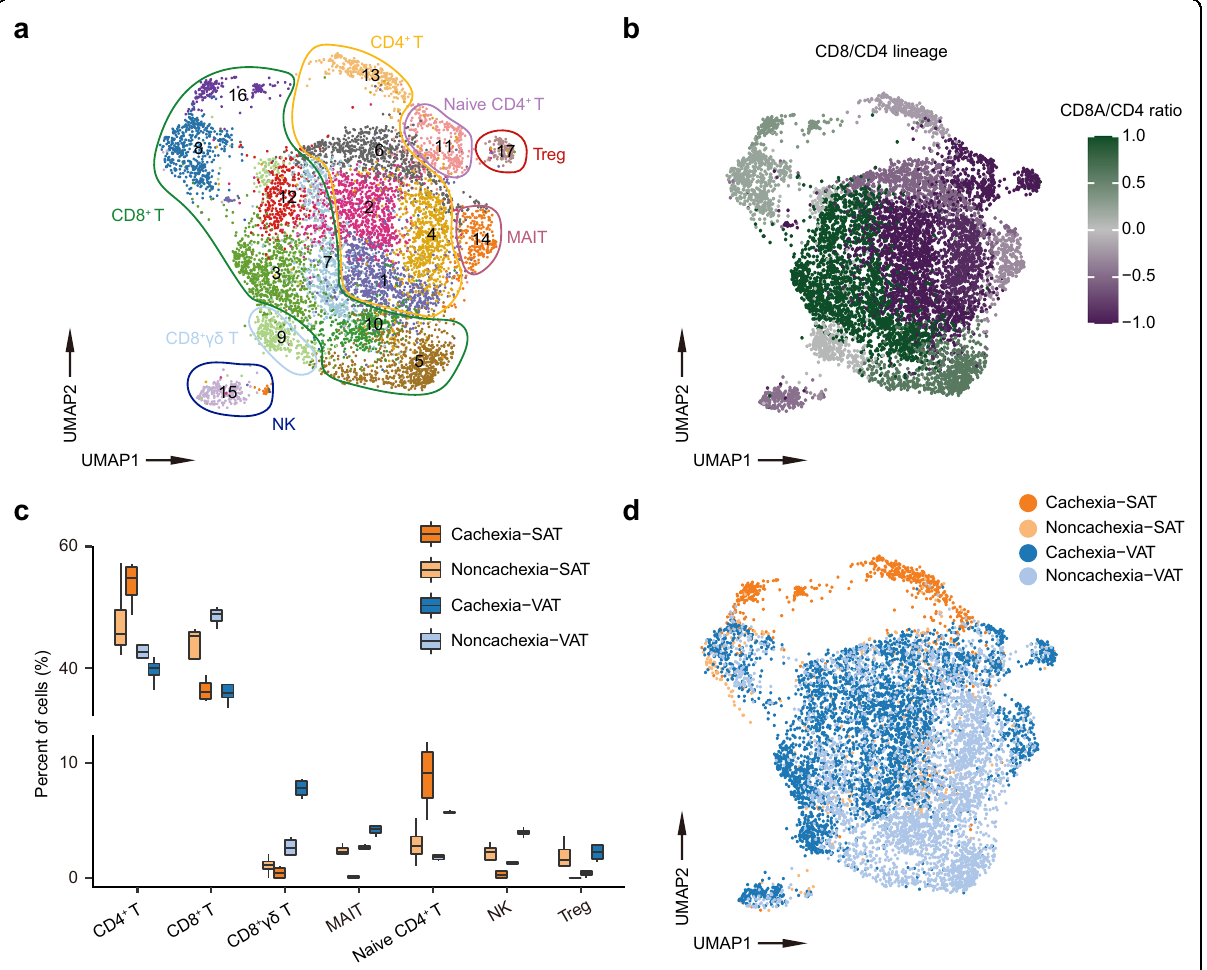
Fig. 5 Landscape of NK/T cells in the SVF. a UMAP plot showing 7 major cell types identi fi ed by manual annotation. b UMAP embeddings of cell clusters colored by the CD8A / CD4 expression ratio (cells in each cluster were assigned the same average value). c Boxplot showing the proportion of T/NK cells derived from patients with ( n = 4) or without ( n = 4) CAC for each cell population. d UMAP plot showing the origin of all NK/T